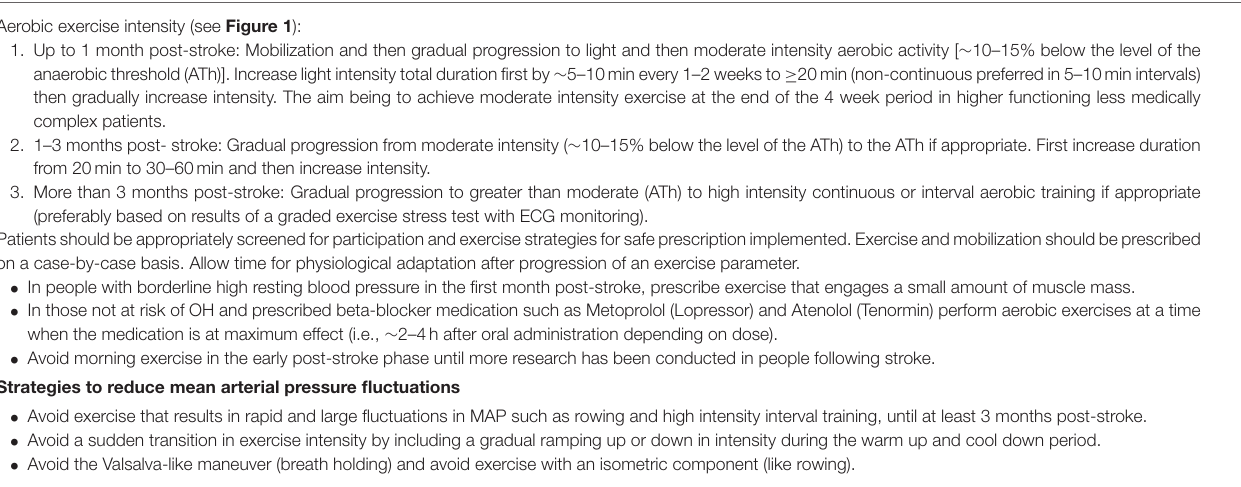
TABLE 7 | Guideline 6.0: Strategies to minimize catecholamine surge and increases in mean arterial pressure. Aerobic exercise intensity (see Figure 1 ): 1. Up to 1 month post-stroke: Mobilization and then gradual progression to light and then moderate intensity aerobic activity [ ∼ 10–15% below the level of the anaerobic threshold (ATh)].Increase lightintensity totalduration firstby ∼ 5–10min every1–2 weeks to ≥ 20min (non-continuous preferred in 5–10min intervals) then gradually increase intensity. The aim being to achieve moderate intensity exercise at the end of the 4 week period in higher functioning less medically complex patients. 2. 1–3 months post- stroke: Gradual progression from moderate intensity ( ∼ 10–15% below the level of the ATh) to the ATh if appropriate. First increase